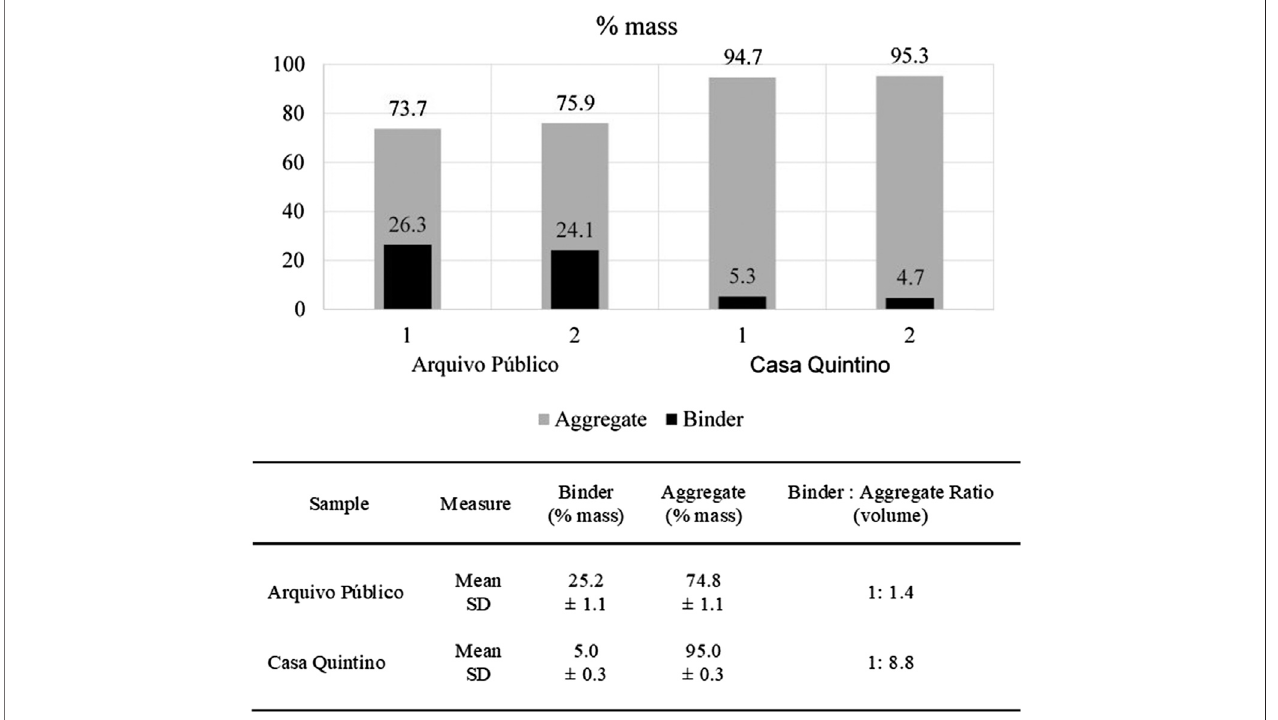
FIGURE 2 | Binder/aggregate ratio estimated by wet chemical